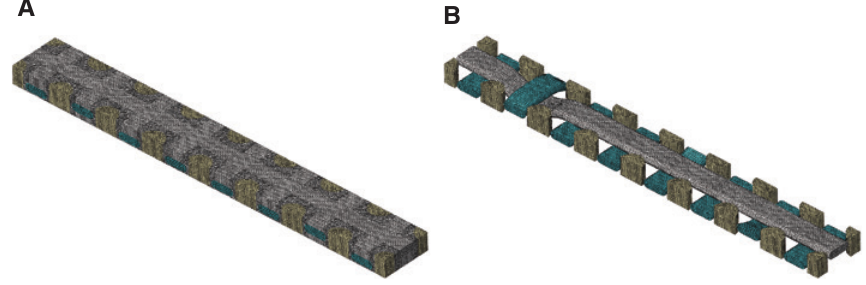
Figure 11: FEM model of ORUC.